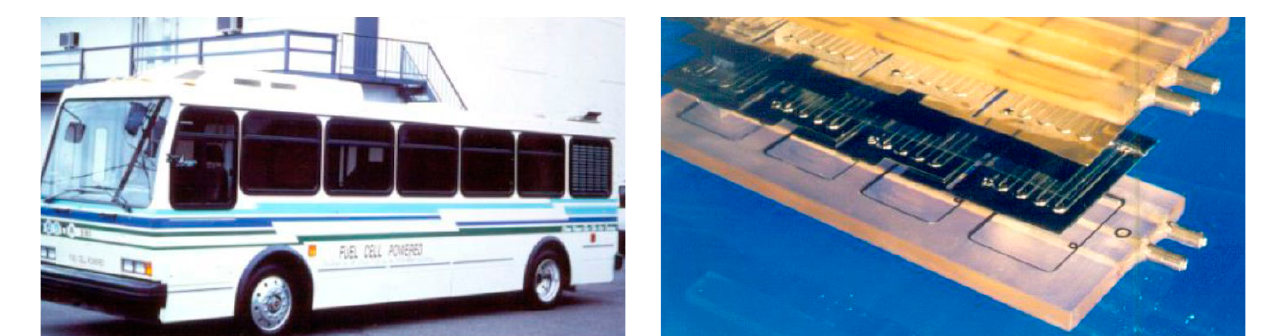
Figure 16. H Power phosphoric acid fuel cell bus, 1996. Courtesy of the US Department of Energy.